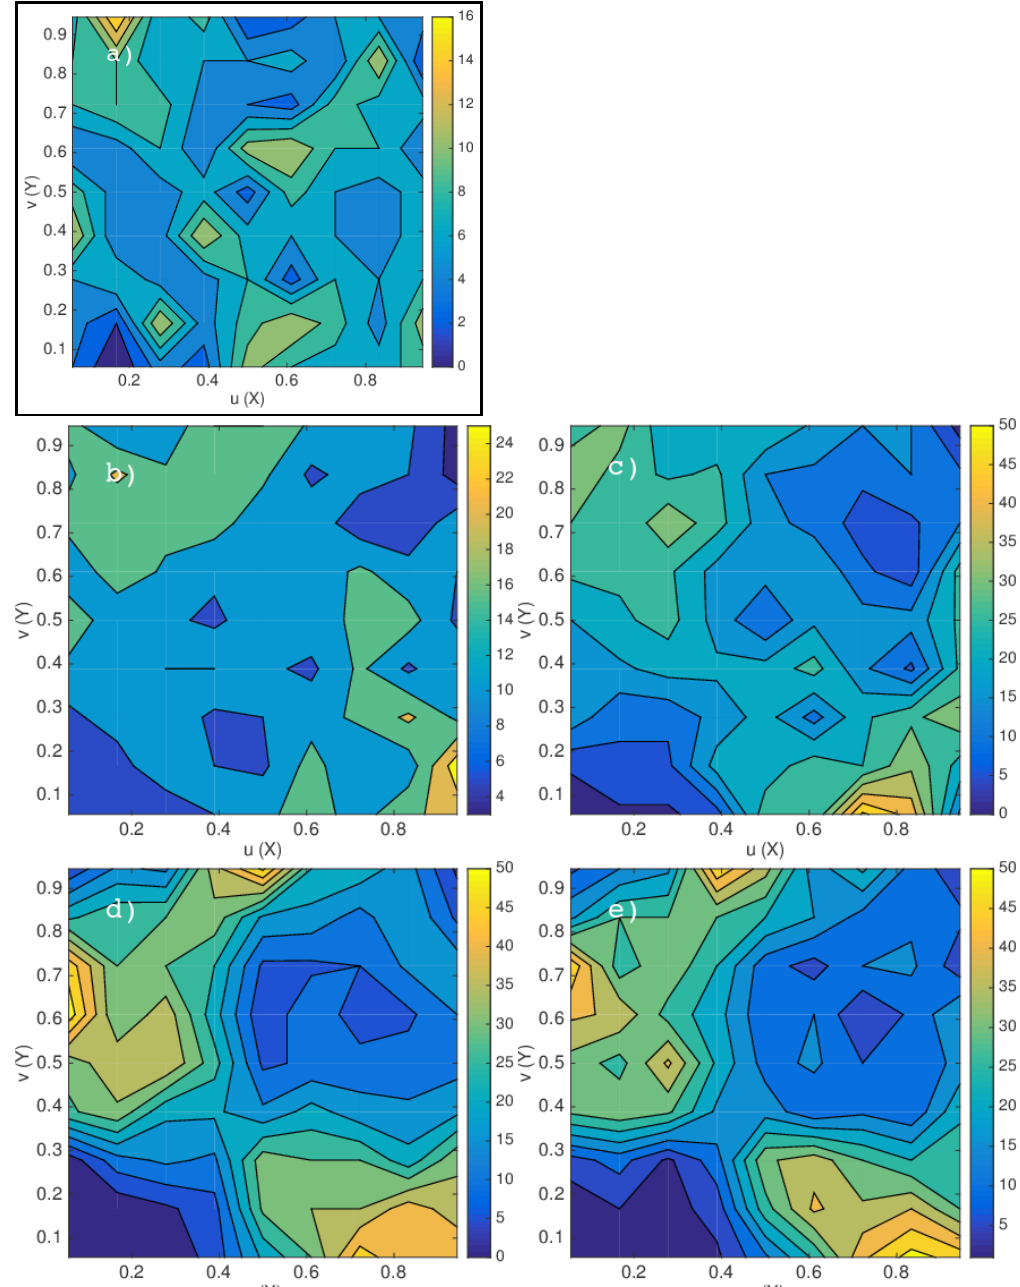
Figure 4. Empirical copula (defined on a 9 × 9 lattice) of the P and T pairs at LAMU station ( X : precipitation, Y : temperature) from ( a ) observations, ( b ) WRF-BLA, ( c ) WRF-GWA, ( d ) WRF-KLA, and ( e ) WRF-KWA. Note that the color bar is not standardized, so as to better recognize structures in Copulas. relatively flat